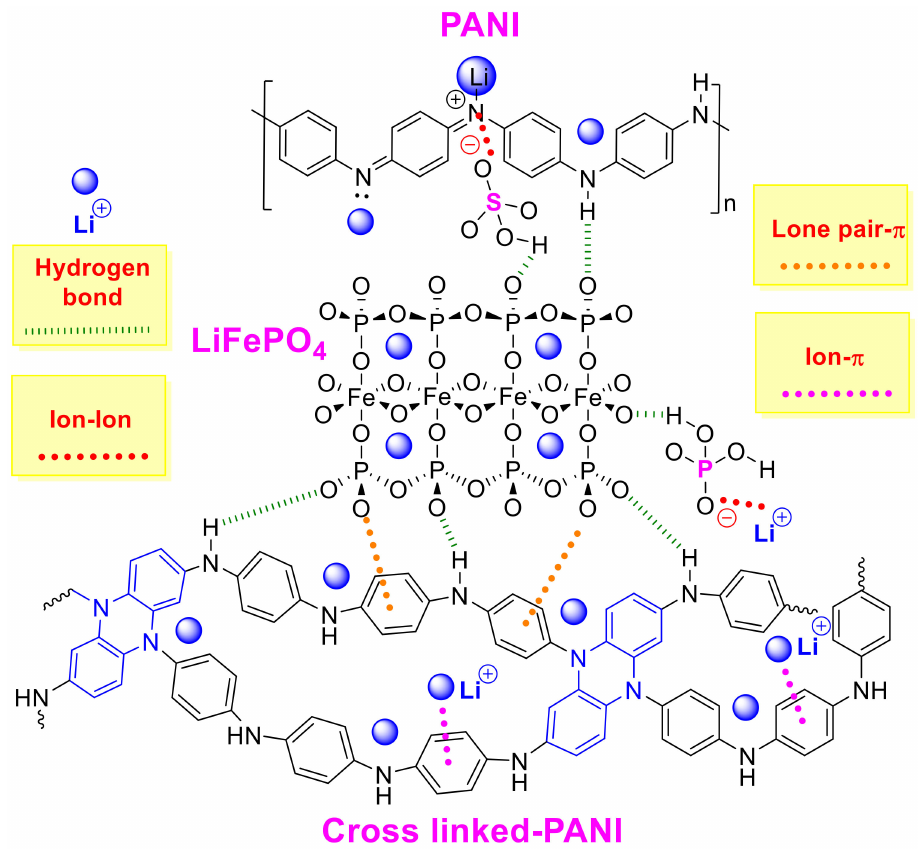
Figure 13. Possible structure of the LiFePO 4 –PANI and its